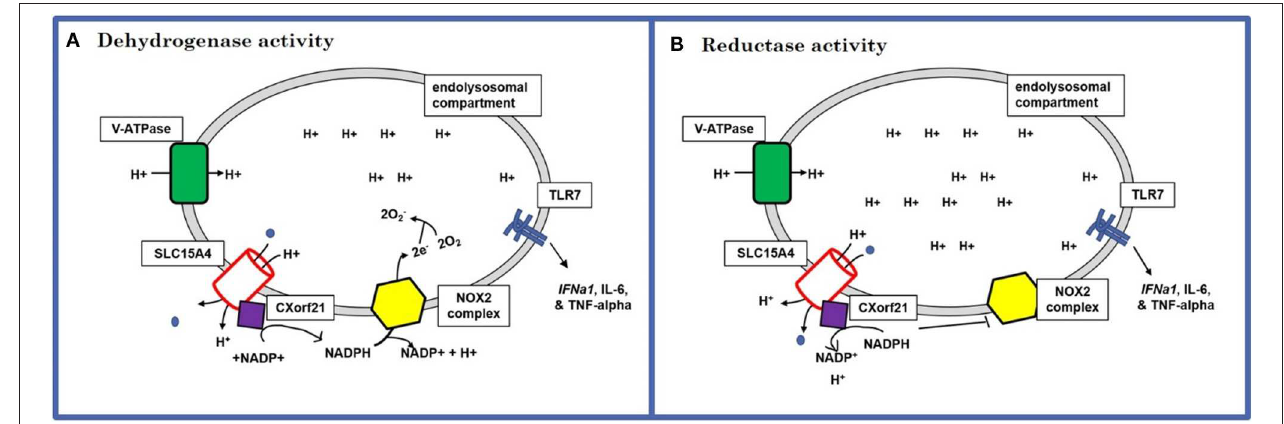
FIGURE 6 | Schematic of the predicted mechanism of action for CXorf21. (A) Dehydrogenase activity: use protons provided by SLC15A4 along with NAPD + to produce NADPH. NADPH can, in turn, be used by NOX2 complex to generate lysosome superoxide necessary for antigen processing (increases lysosomal pH). (B) Reductase activity: sequesters NAPDH to generate NAPD + and protons. This could result in increased available hydrogen ions for proton transporters and pump, as well as limit NOX2 ability to produce superoxide anions (decrease lysosomal